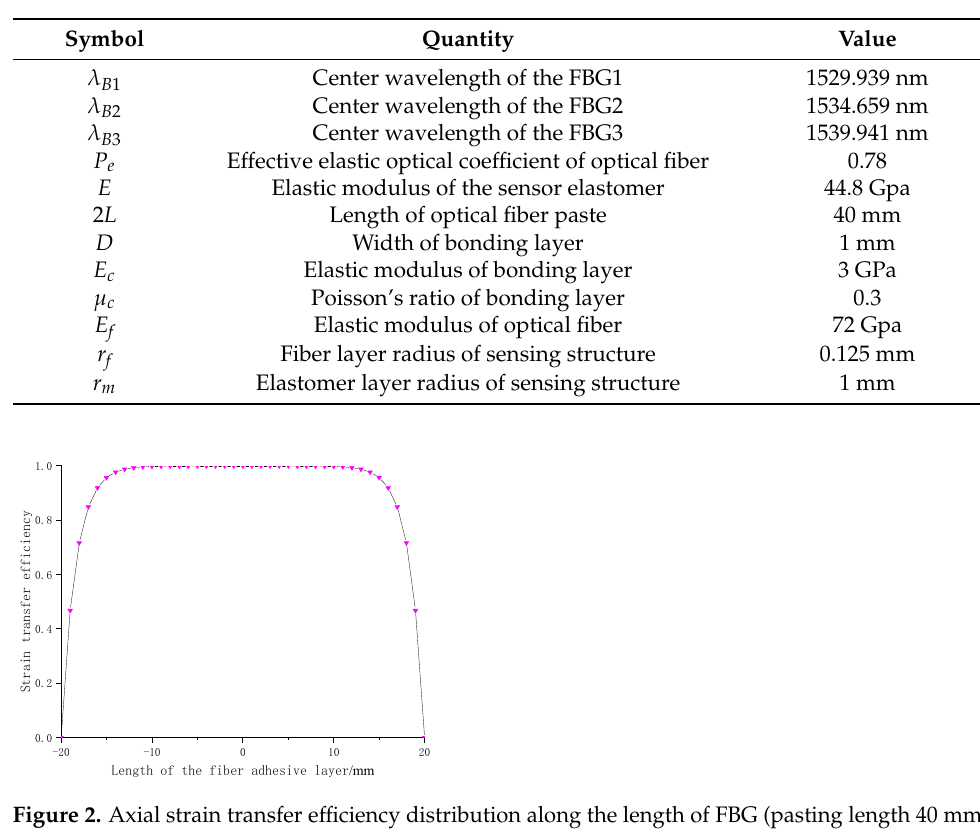
Table 1. Structural material parameters of FBG three-dimensional stress sensor.